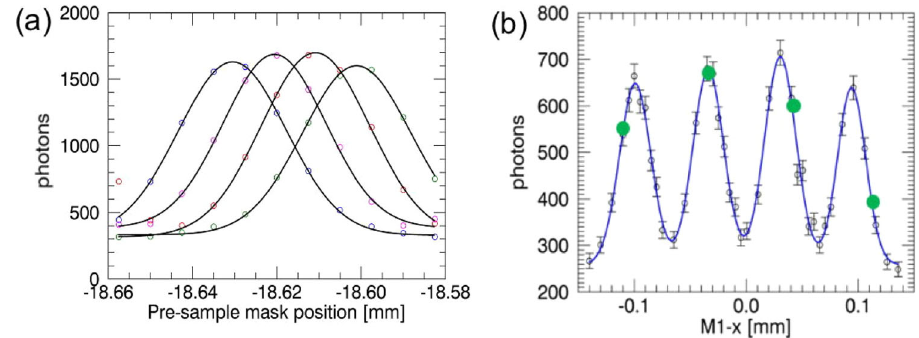
deviation) represent a fi nely sampled version, the solid blue curve the 4-Gaussian fi t, and the green dots represent typical sampling points in an object scan, deter- mined by the relative positions of sample and detector masks. Note these corre- spond to a certain fi xed position of the pre-sample